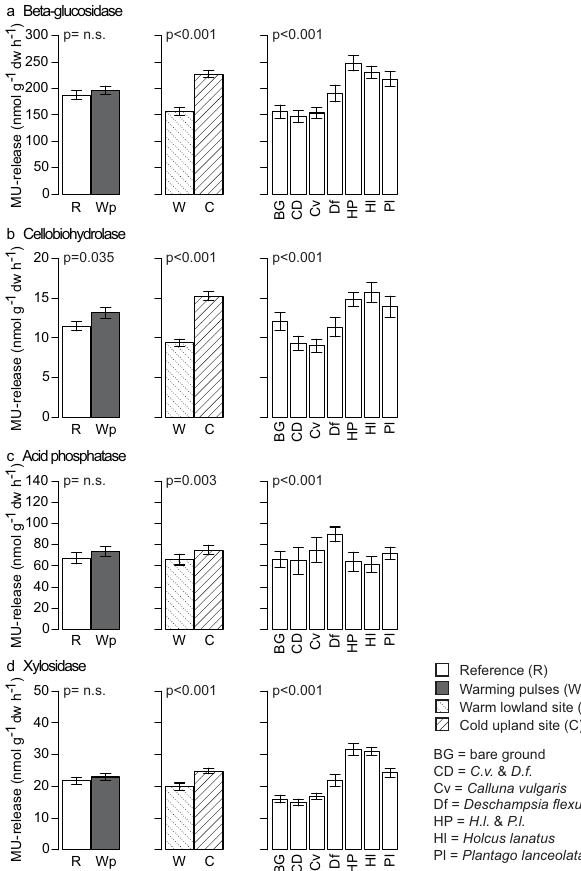
Figure 3. Mean potential soil enzymatic activity for the four tested enzymes (a) β -glucosidase, (b) cellobiohydrolase, (c) acid phos- phatase and (d) xylosidase (all ± SE) during the manipulation pe- riod (18 December 2010–17 March 2011). Main winter warming pulses treatment, site and community effects are shown. No signifi- cant interactions between the winter warming pulses treatment with site and community were